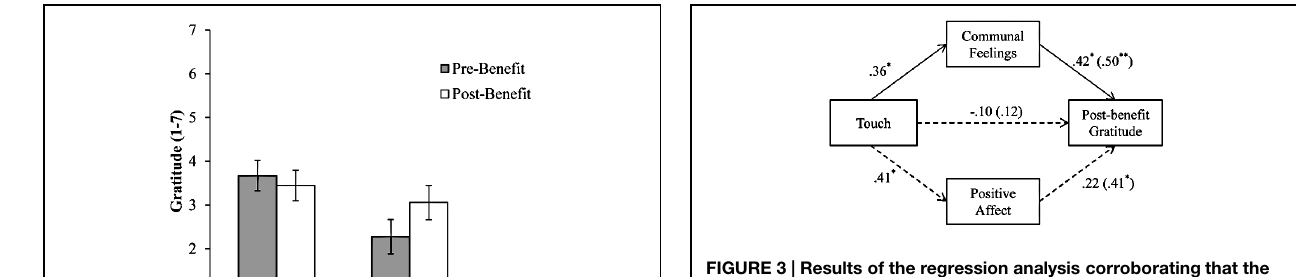
FIGURE 3 | Results of the regression analysis corroborating that the effect of touch on post-benefit gratitude is mediated by communal feelings (vs. positive affect) in Study 1. The numbers are standardized regression coefficients. The numbers outside parentheses represent β -weights when all variables are used concurrently as predictors, whereas the numbers in parentheses are zero-order correlations. ∗ p < 0.05; ∗∗ p <